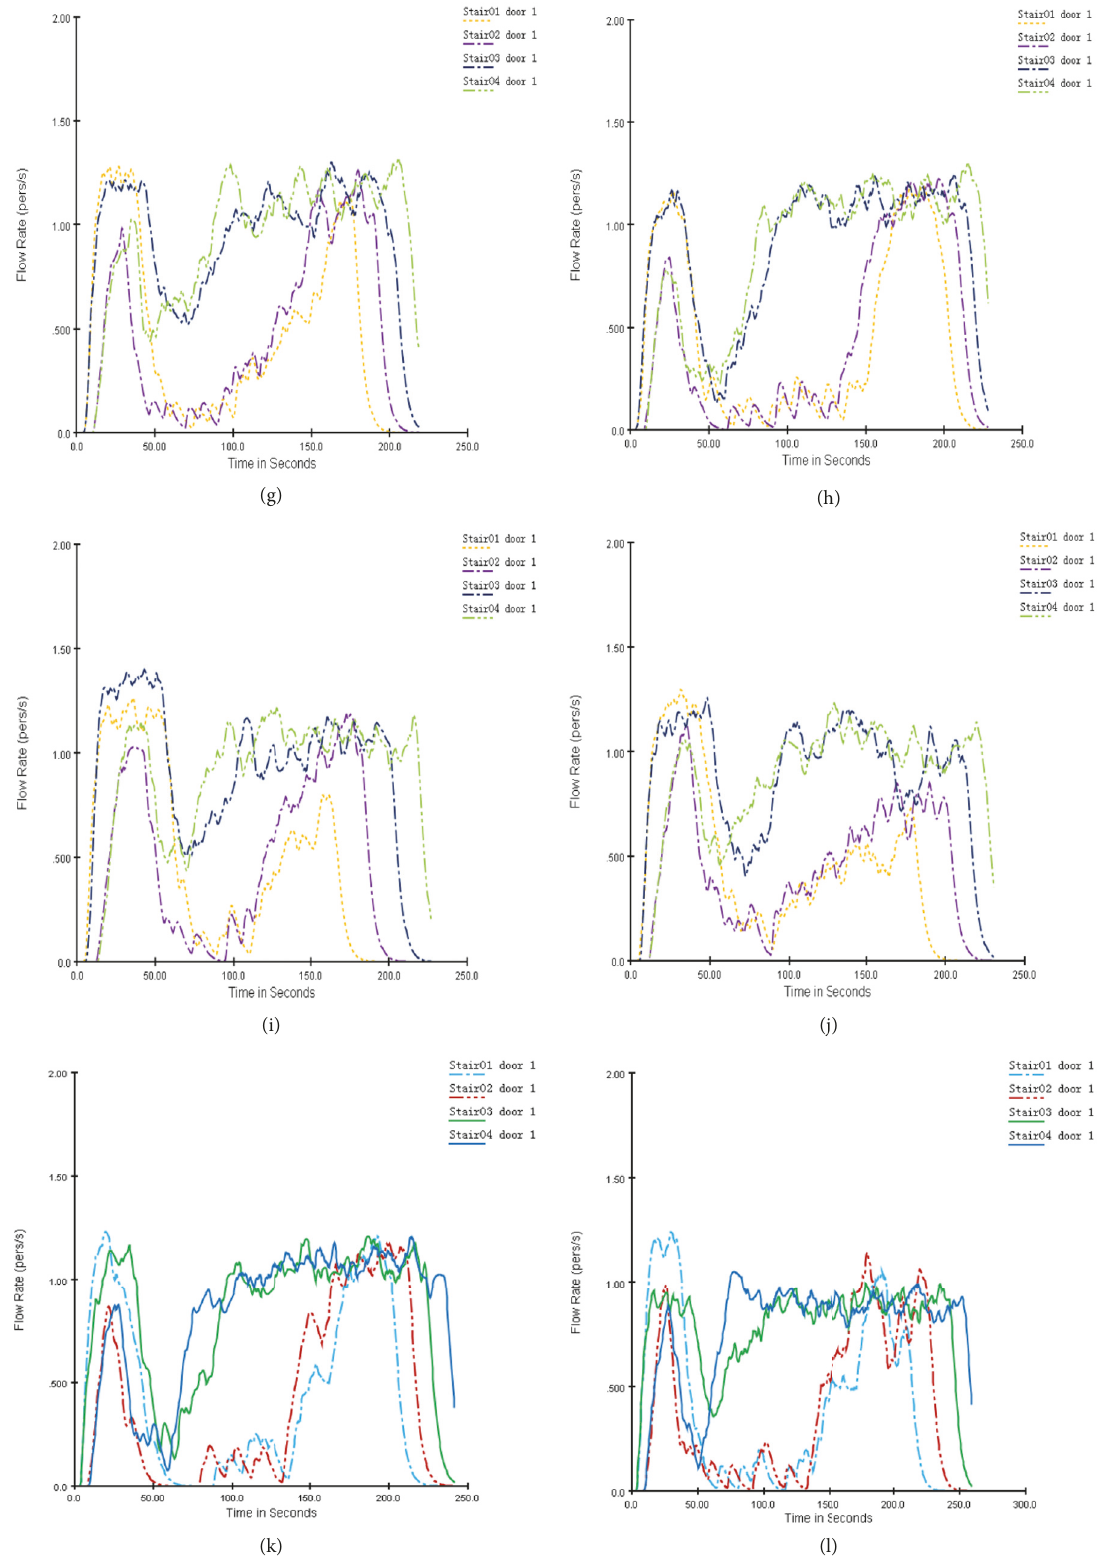
Figure 9: The flow rate of stairs in each merging forms. (a) type1; (b) type2; (c) type3; (d) type4; (e) type5; (f) type6; (g) type7; (h) type8; (i) type9; (j) type10; (k) type11; (l)